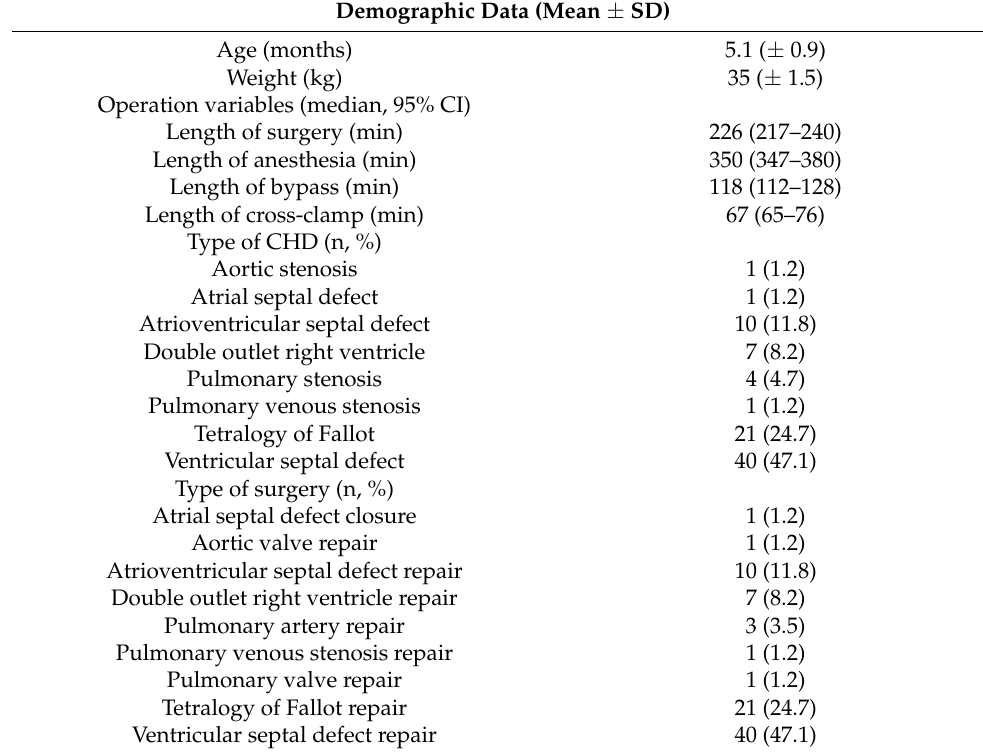
Table 1. Demographic and surgical